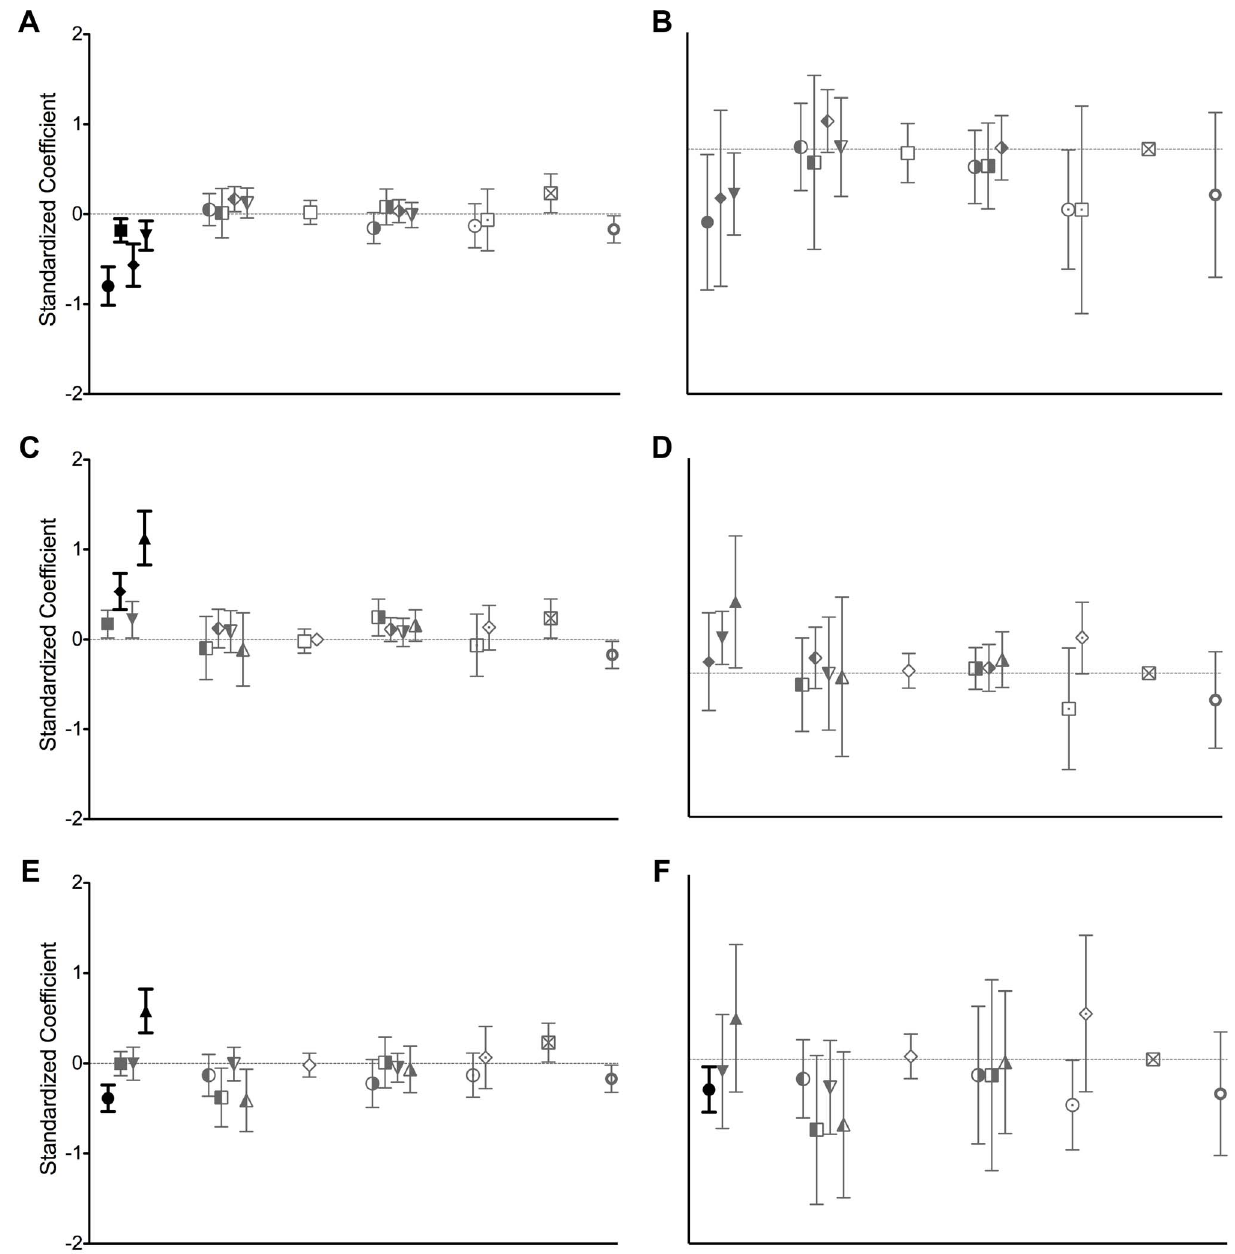
Figure 3. Standardized coefficients for predictors of viral substitution rates. Standardized coefficients with 95% confidence intervals for the different predictor variables of structural (left) and non-structural (right) gene substitution rates. A and B show the coefficients from the first ANCOVA analysis, C and D show coefficients from the second ANCOVA analysis, and E and F show coefficients from the third ANCOVA analysis. Coefficients are indicated by the same symbols used in Figures 1 and 2. Dark coefficients correspond to significant substitution rate predictors ( P , 0.01: neural, leukocyte, hepatocyte, and epithelial target cells in A, leukocyte and epithelial target cells in C, neural and epithelial target cells in E, and neural target cells in F), while the other coefficients are shown in gray. with their corresponding substitution rate estimates ( r = 0.69, P = 0.31 and r = 2 0.93, P =0.25, for mutation rates measured as mutations per base per infection and mutation rates measured as mutations per base per replication, respectively). Similarly, there were no significant correlations between the estimated substitution rates and dN/dS estimates ( r = 2 0.02, P = 0.88 and r = 2 0.07, P = 0.68, for the limited structural gene and non-structural gene datasets, respectively).